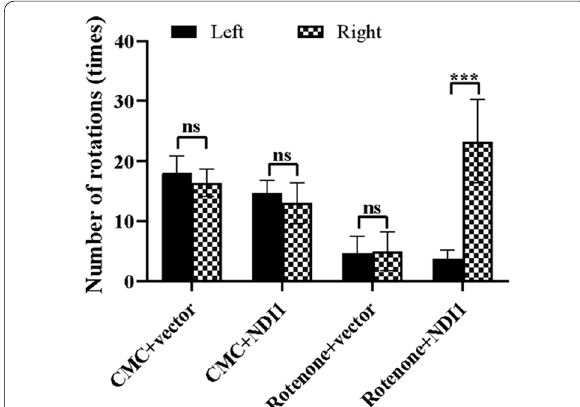
Fig. 6 Rotation test to examine the therapeutic effect of NDI1 on ipsilateral neuropathy in rotenone-induced PD mouse model. Apomorphine induced the mice to rotate toward the healthy side. The AAV5-NDI1 was injected into the right SNpc. To compare the difference between the leftward and rightward number of rotations in each group, ns no significant. *** P < 0.001